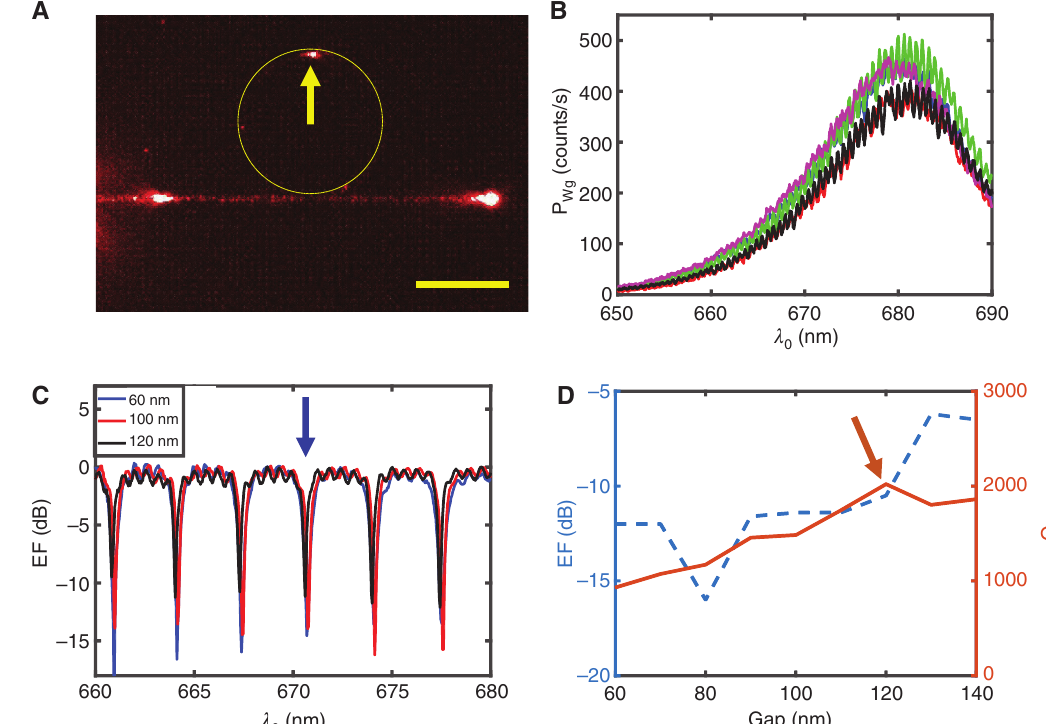
Figure 9: (A) Optical image captured on the CCD camera for bus-waveguide excitation of a resonator. The scattering spot at the location of the arrow results from scattering of light coupled in the resonator by the QD aggregate.(B) Raw spectra recorded at the end of reference bare (no-ring) waveguides. (C) Spectra recorded at the output port under bus-waveguide excitation of the resonators for different separation gaps. The spectra are plotted relative to the average reference bare waveguide spectrum. (D) Quality factor and extinction factor (relative to the average reference bare waveguide) of the dip (close to 670 nm) for different separation gaps. Gaps of g = 80 nm and g = 120 nm correspond, respectively, to the critical coupling condition and lowest loss